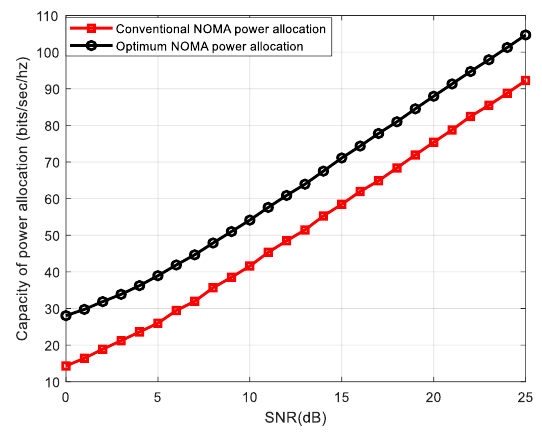
Figure 2. Two user case Capacity vs. SNR (dB); SNR ranges from 0 to 25 (dB).